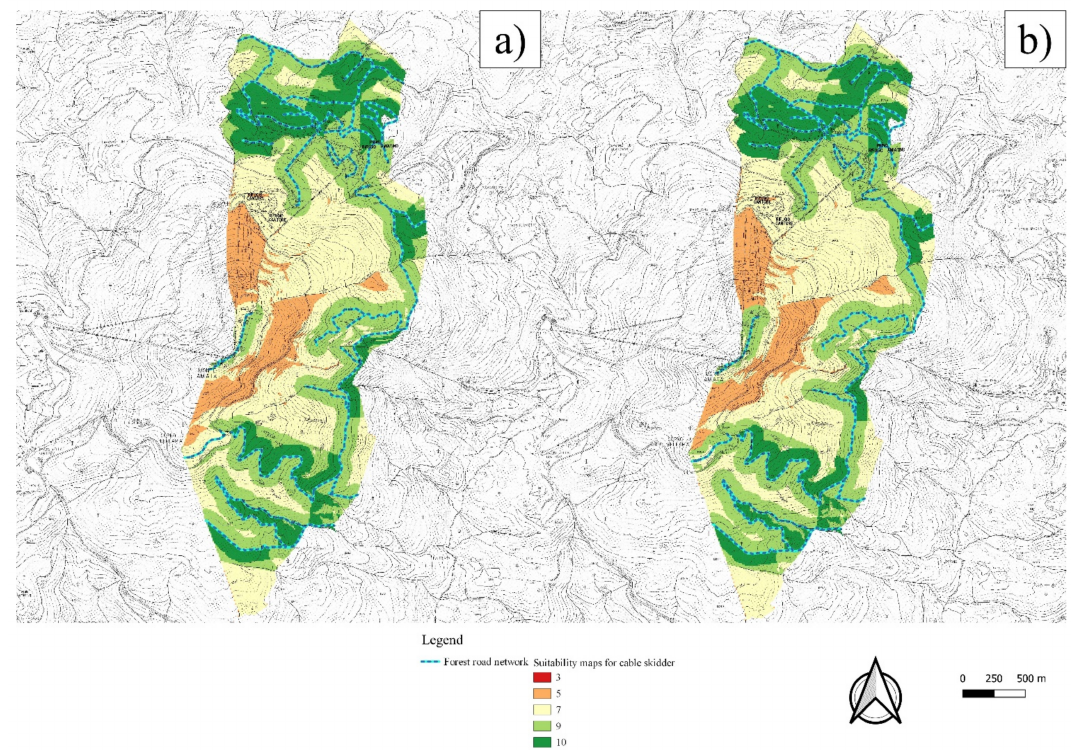
Figure 3. ( a ) Suitability map for forwarder, derived from the analysis with RTS input data. ( b ) Suitability map for forwarder, derived from the analysis with OS input data.